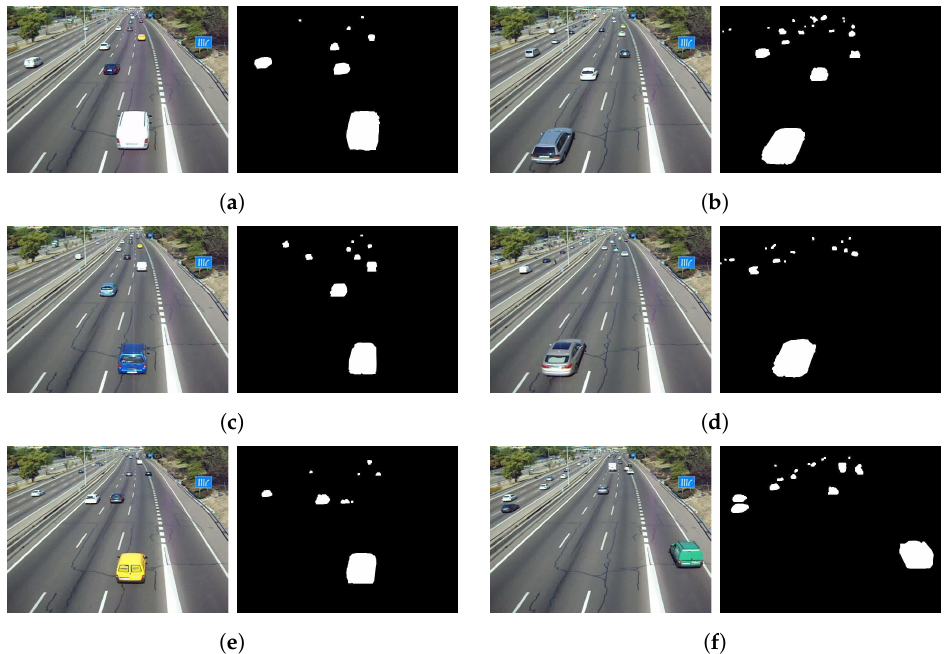
Figure 10. Detection for vehicles of different colors. ( a ) White vehicle. ( b ) Silver vehicle. ( c ) Blue vehicle. ( d ) Brown vehicle. ( e ) Yellow vehicle. ( f ) Green vehicle.